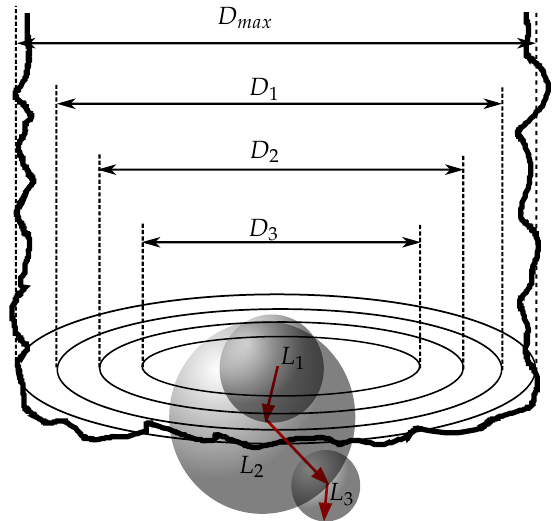
Figure 3. Stepped leader progression